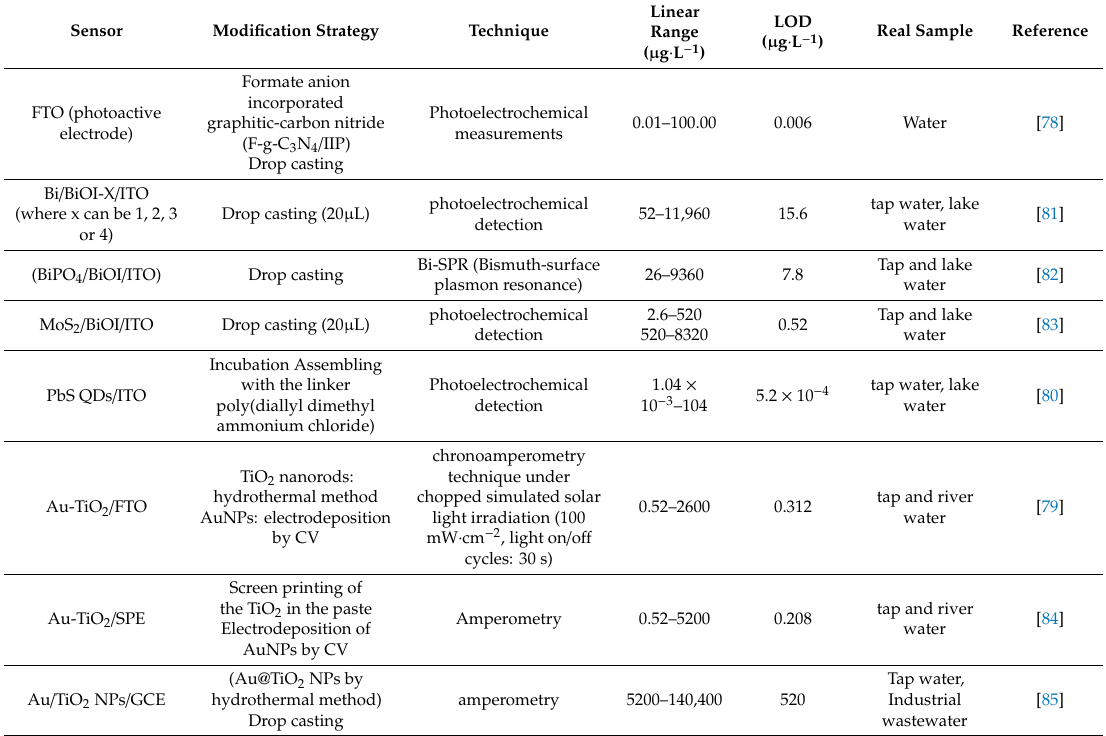
Table 4. Summary of the electroanalytical data of reported photoelectrochemical sensors for hexavalent chromium